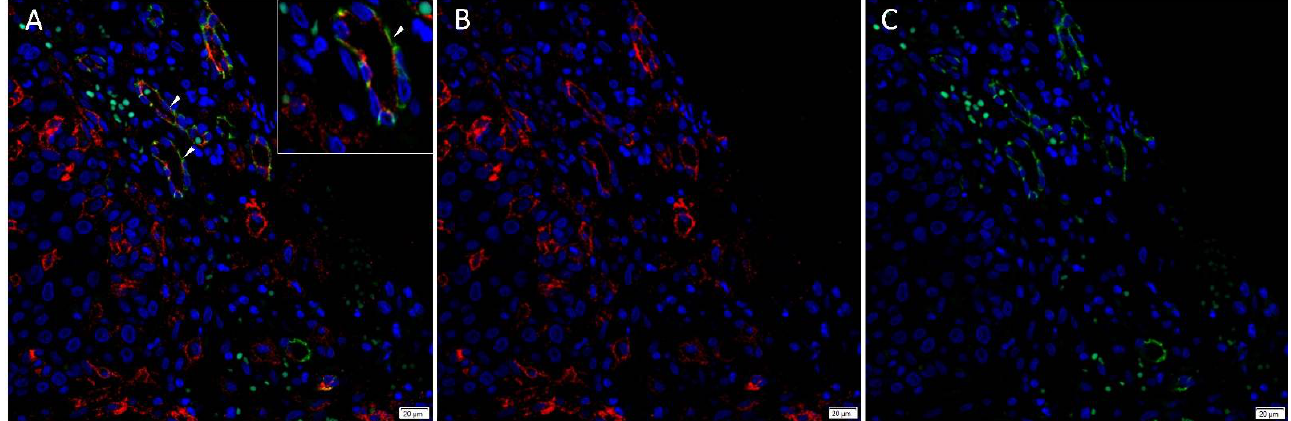
Figure 3. Representative merged and split immunofluorescence-stained sections of metastatic head and neck cutaneous squamous cell carcinoma demonstrating the expression of PRR ( A , B , red) by SOX2+ ( A , C , yellow) CSCs throughout the tumor nests (TNs, arrows ) and the peritumoral stroma (PTS, arrowheads ). Cell nuclei were counter-stained with 4′,6- diamidino-2-phenylindole ( A – C , blue). The inserts show enlarged views of the corresponding images Original magnification 400×. n = 2.